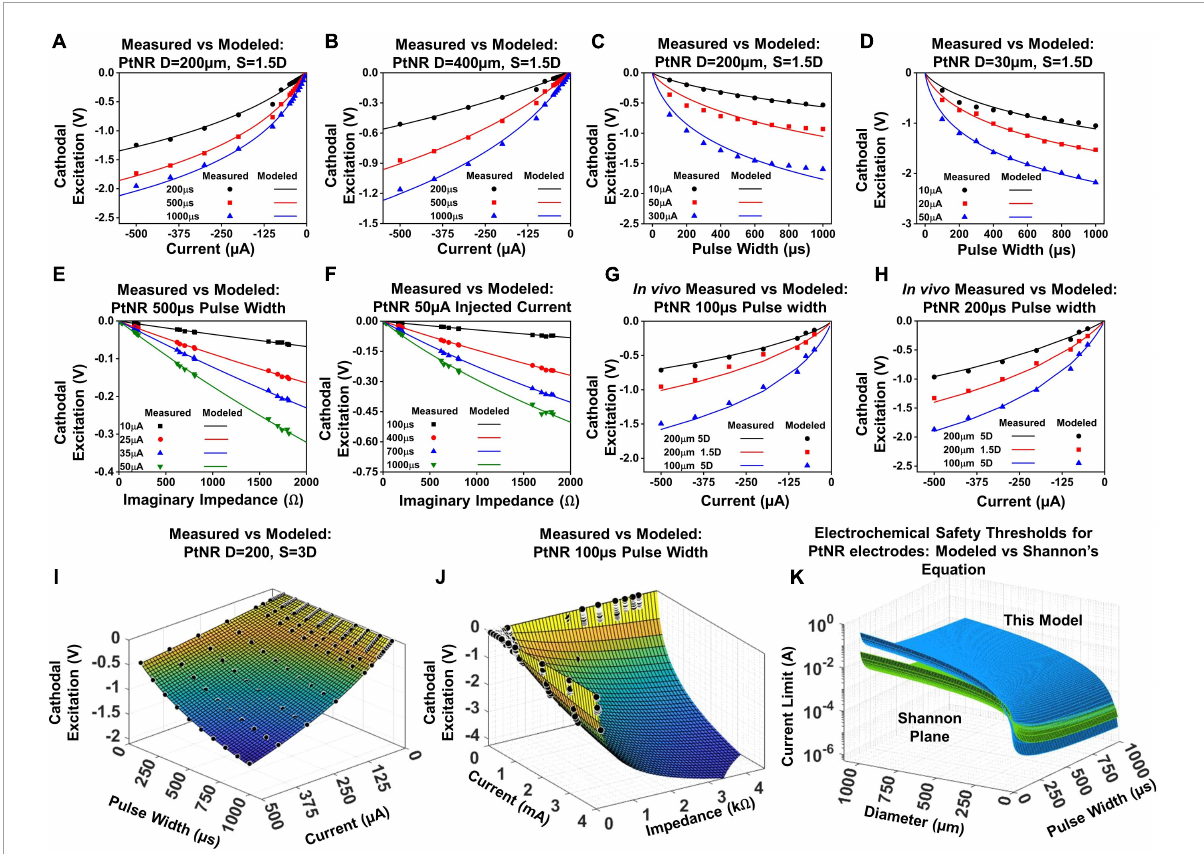
FIGURE7 Modeled vs. predicted cathodal excitation in benchtop as a function of (A,B) current for a (A) 200 µ m and (B) 400 µ m contact, (C,D) pulse width for a (C) 200 µ m and (D) 400 µ m contact, (E,F) Reactance at 10 kHz for a (E) 200 µ m and (F) 400 µ m contact. (G) and (H) In vivo comparison of the equation performance for measured cathodal excitation in a rat experiment. (I) Fit for the cathodal excitation as a function of the pulse width and current. (J) Fit for the cathodal excitation as a function of the impedance and current. (K) The safety limit determined by the modeled equation in this work in comparison to the limits defined in the Shannon’s